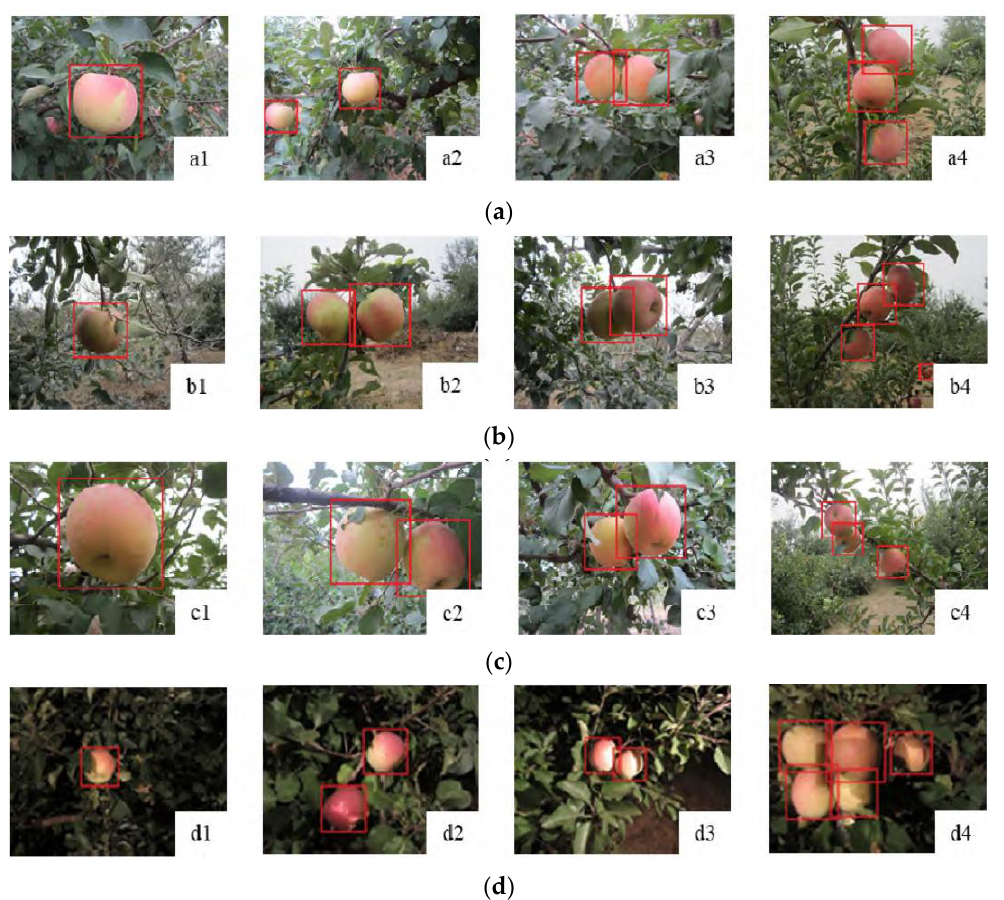
Figure 8. Detection results of different images: ( a1 – a4 ) images taken under front light; ( b1 – b4 ) images taken under backlight; ( c1 – c4 ) images taken under side light; ( d1 – d4 ) images taken under artificial light (Photo: Reprinted with permission from Ref. [60]. 2019, Liu X.).